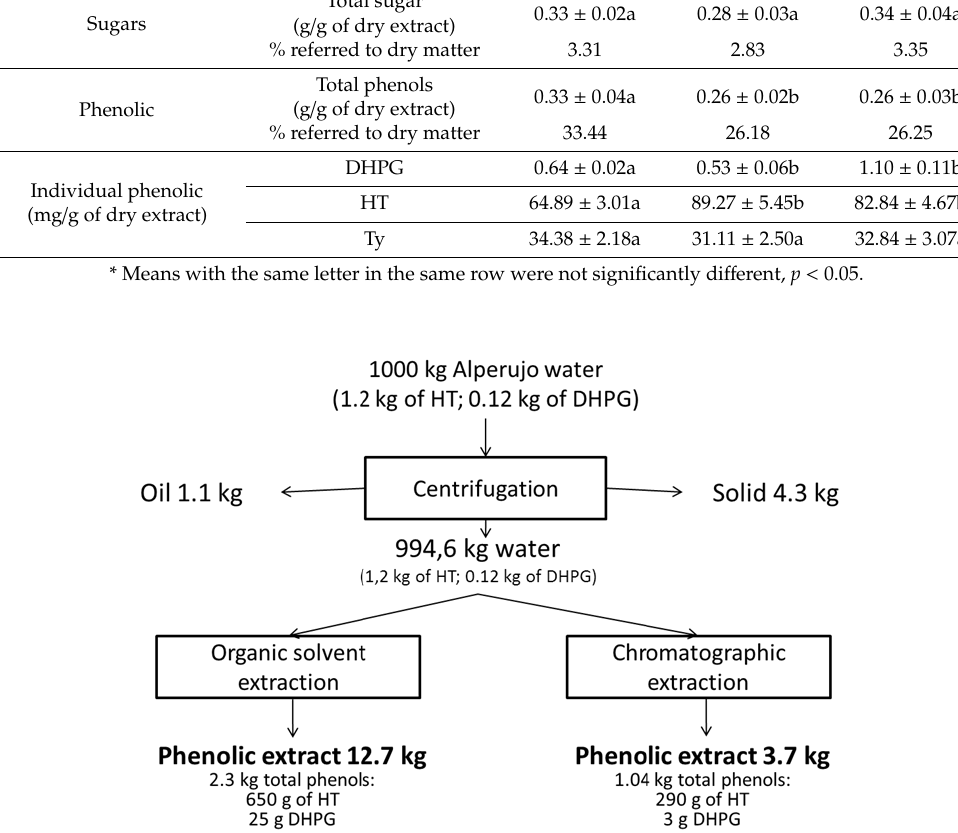
Figure 1. Balance of the two extraction systems from alperujo water referring to the overall extract from the three depths.